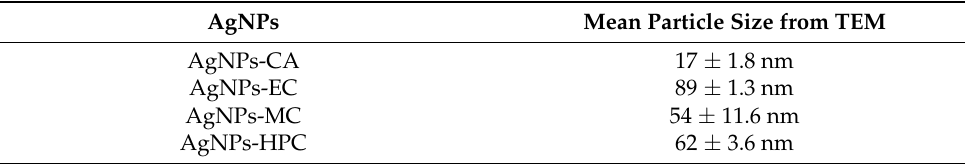
Table 2. Particle size and spectral features of AgNPs determined using